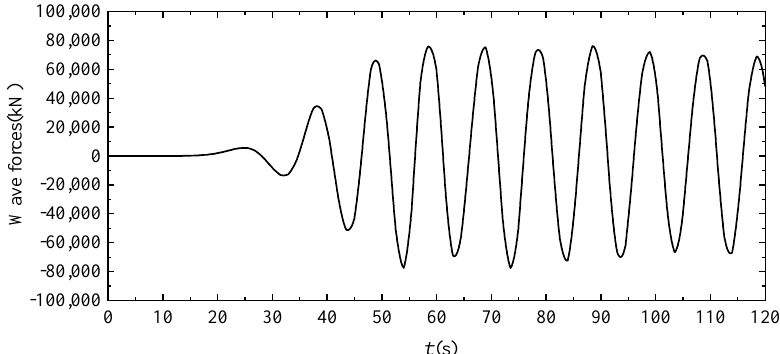
Figure 12. Time history of wave-induced dynamic force exerted on the dumbbell cofferdam in the wave propagation